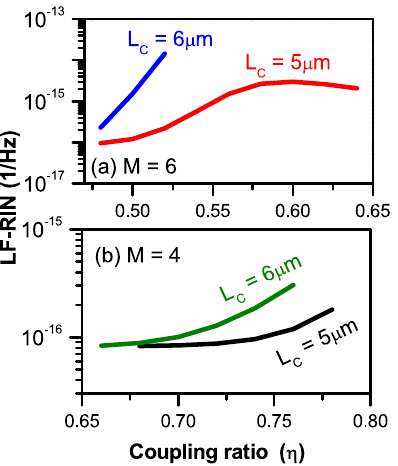
Figure 9: Variation of the LF-RIN level of (a) the 4TCC-VCSEL and (b) 6TCC-VCSELwhen the TCC length is L C = 5 and 6 μ